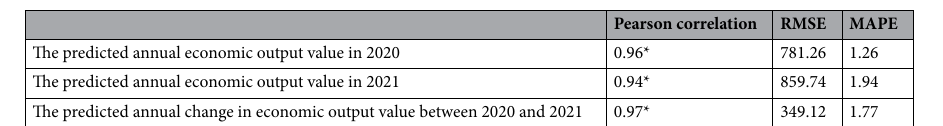
Table 5. Similarity metrics between the observed and predicted economic dynamics using developed GWR models. *P < 0.01.